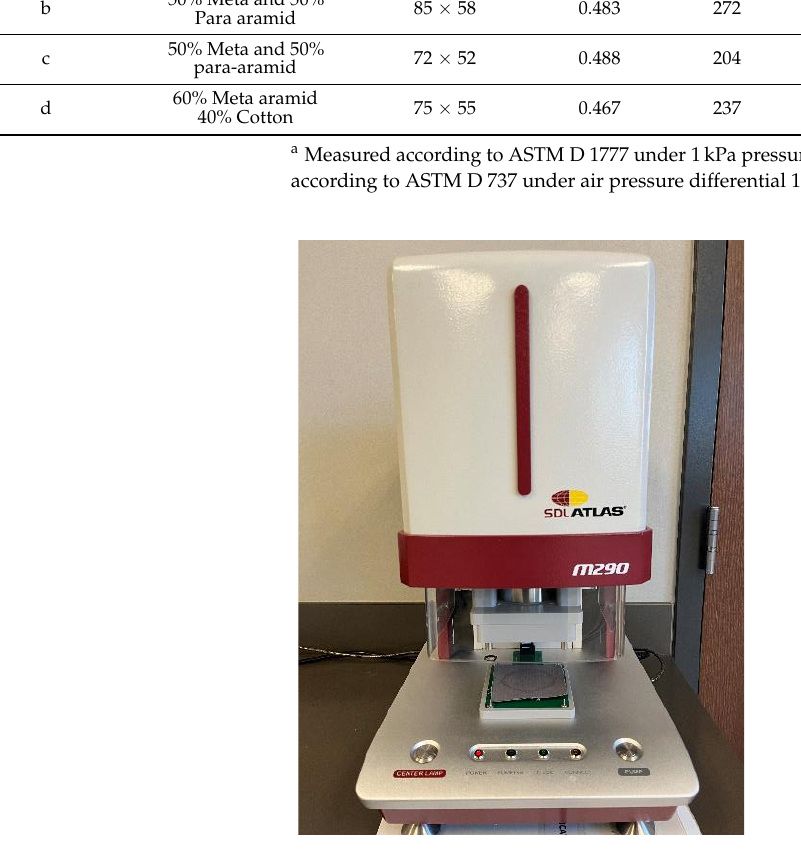
Figure 1. Moisture Management Tester as per AATCC 195 method.